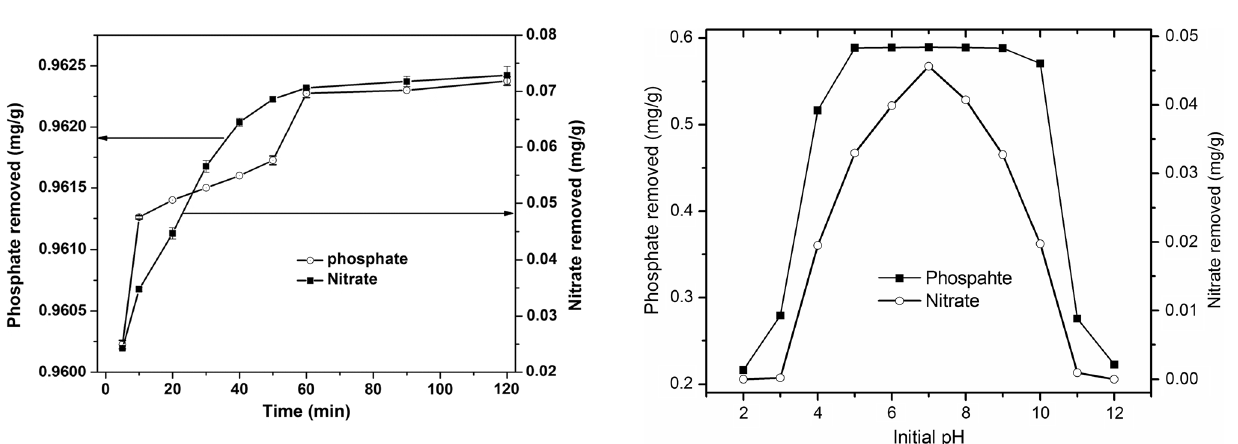
Fig. 2 Effect of pH on the simultaneous removal of nitrate and phos- phate